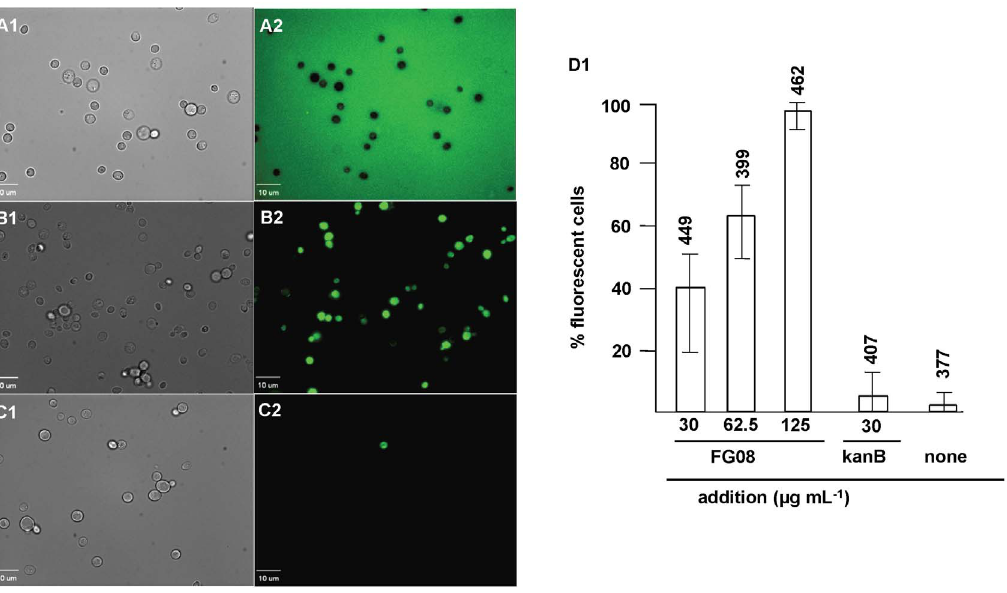
Figure 2. Membrane perturbation effects of FG08 on intact cells of S.cerevisiae strain W303C. FITC dye uptake without (A1, A2) and with FG08 (30 m g mL 2 1 ) (B1, B2) or kanamycin B (30 m g mL 2 1 ) (C1, C2) exposure for 10 min. Bright-field images (A1, B1 and C1) are compared with fluorescence images (A2, B2, and C2) to calculate % fluorescent cells that are stained with FITC. Image A2 (no FG08 and no kanamycin B) shows no fluorescent cells against a fluorescent background. Bar length is 10 m m. Panel D1 shows dose-dependent effects of FG08 on FITC dye uptake and effects of kanamycin B and no treatment. Triton X-100 H (1%, vol vol 2 1 ) gave 100% dye influx (data not shown). The range bars show variations in % fluorescent cells from analyses of 10 separate microscopic image fields randomly selected from at least two separate experiments. Numbers above the range bars indicate the number of cells analyzed.